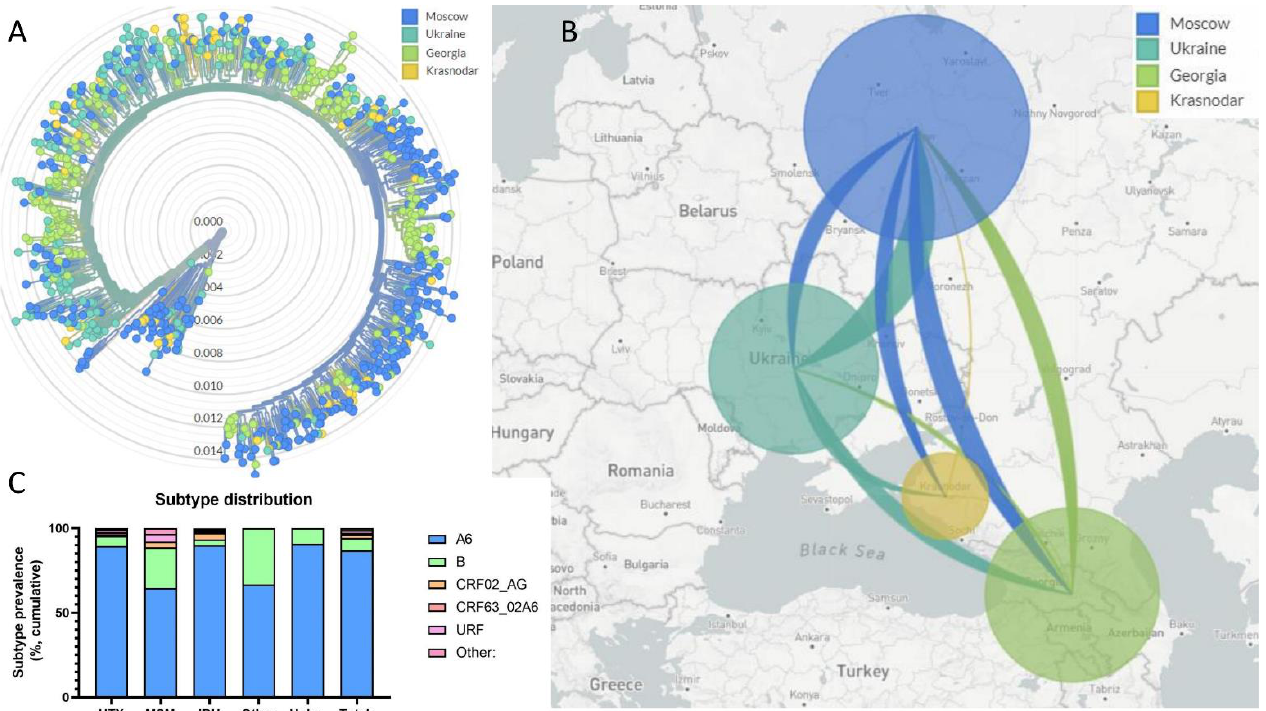
Figure 2. ( A ): Phylogenetic relation between the HIV-1 strains coloured by the locations where the viruses were obtained. The central cluster are the subtype B sequences; the small, Moscow-based cluster between this cluster and the main cluster are the genotype G sequences. The big cluster on the outside are the sub-subtype A6 sequences. The numbers indicate the genetic distance (divergence) between the viruses. The tree was rooted on a subtype D sequence (D.K0345). ( B ): The most likely transmission routes were inferred from the phylogenetic analysis depicted in panel A using the nextstrain workflow. Directionality of transmissions is pictured by the connecting lines, which have the colour of the country from which the transmissions took place. The surface area of the circles represents the number of cases analysed in each region. ( C ): Subtype distribution by transmission route. For transmission route categories see Table 3 legend.